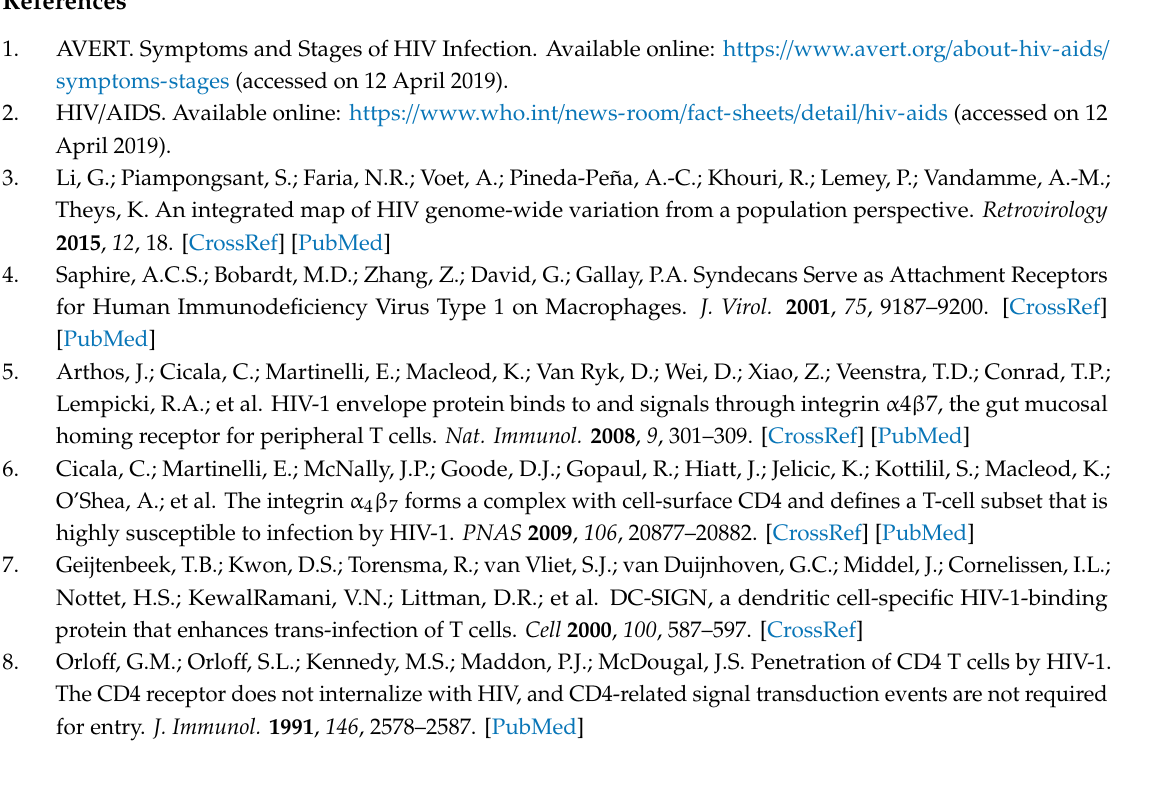
table. S.K.P. participated in the manuscript writing and wrote and discussed parts relevant for clinical applications, shaped the paper concept, and performed the final